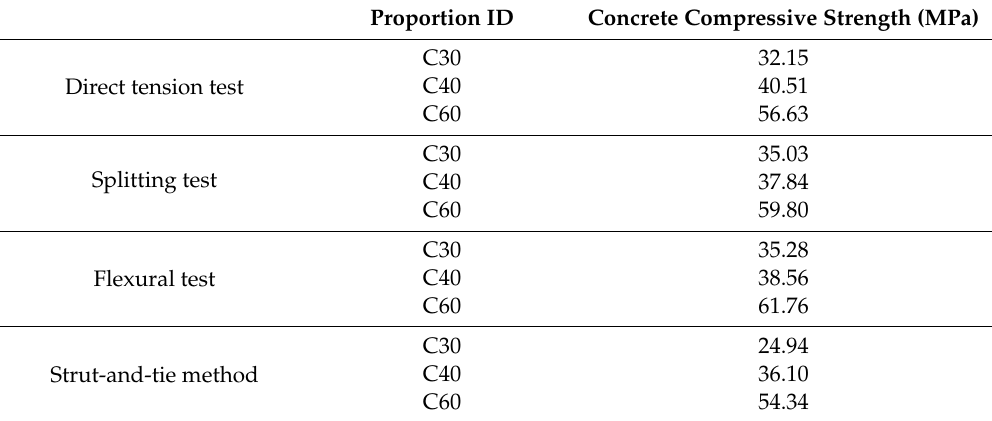
Table 5. Summary of compression test results.